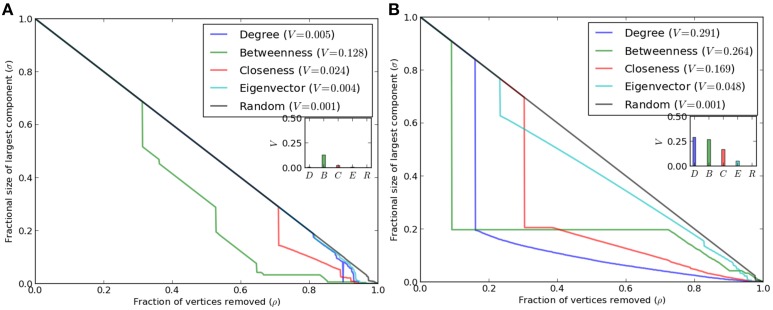
Analysis of topological robustness of the both networks (A) R. serpentina and (B) C. roseus via plotting of a sequential node deletion against changes in the size of the largest component, σ(ρ), when the fraction ρ of the vertices (nodes) was removed. The results indicate the high network robustness of R. serpentina as compared to C. roseus.